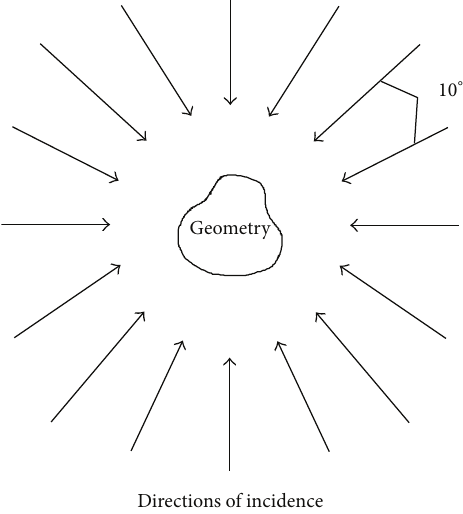
Figure 1: Generation of